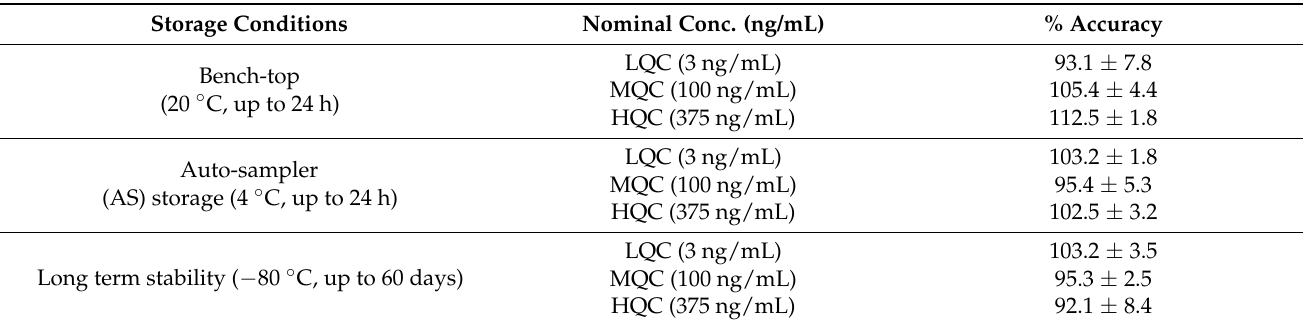
Table 4. Stability of indole was tested in mouse plasma at different storage conditions, (Mean ± SD, n =